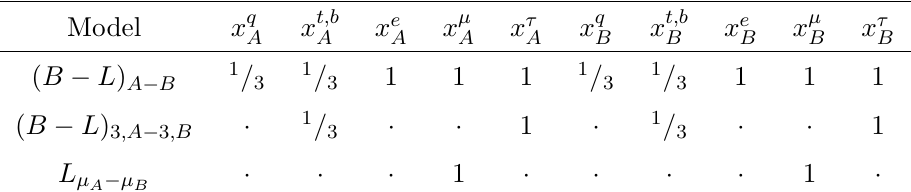
Figure 5 . Universal ( B (cid:0) L ) model . Top left panel: the production cross-section at and the 95% C.L. limit from the ATLAS dijet resonance search [105]. Top right panel: the ratio of the production cross-section to the SM Z cross-section at from the CMS dilepton search in the dimuon channel [106]. Bottom panel: the recast ATLAS and CMS limits on r X